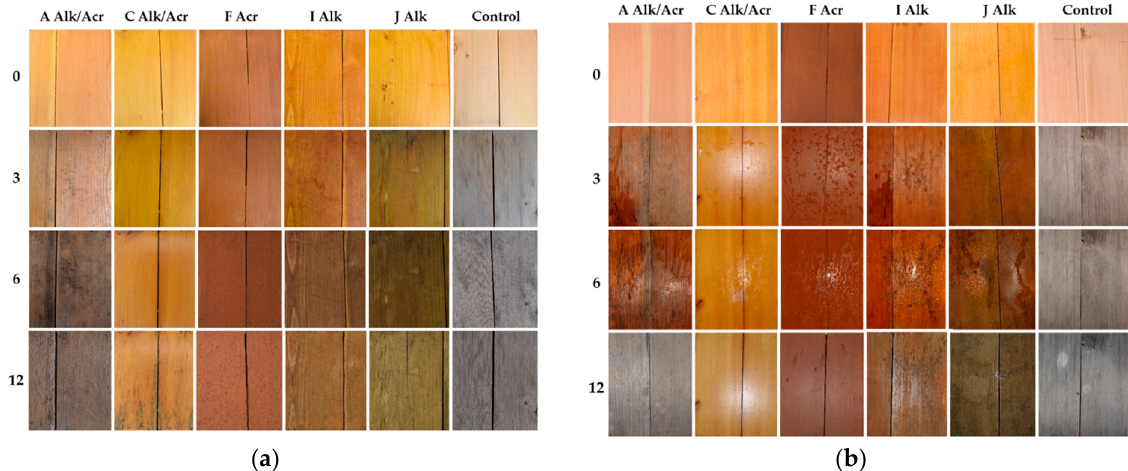
Figure 3. Visual changes of uncoated and coated CLT samples after twelve months of natural weathering in ( a ) Mississippi and ( b ) Wisconsin .